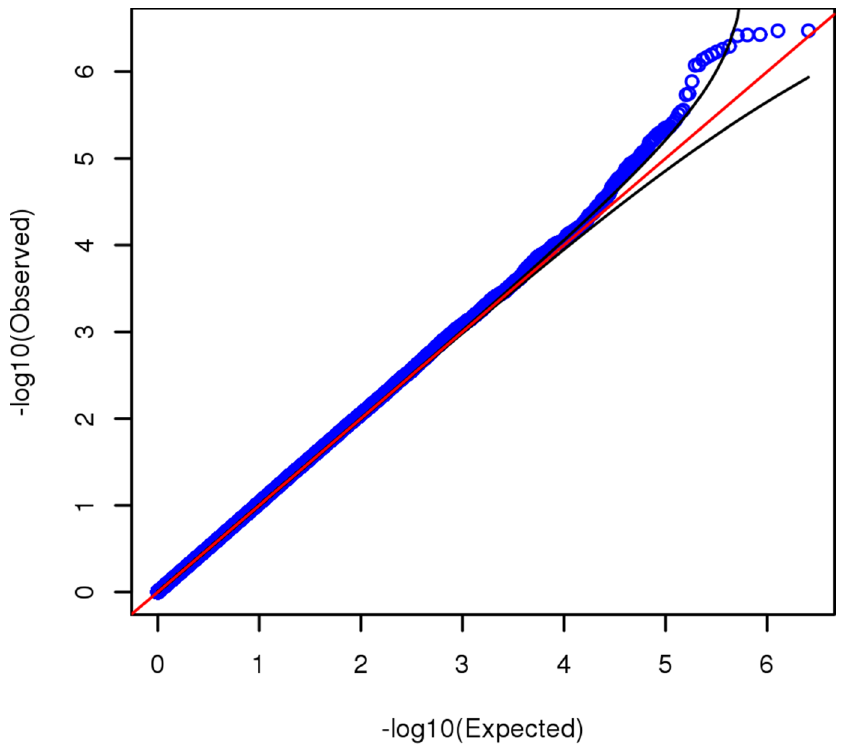
Figure 2. Uniform quantile-quantile plot of GWAS p -values, all 2,546,647 observed and imputed SNPs. The black curves delineate 95% confidence limits.